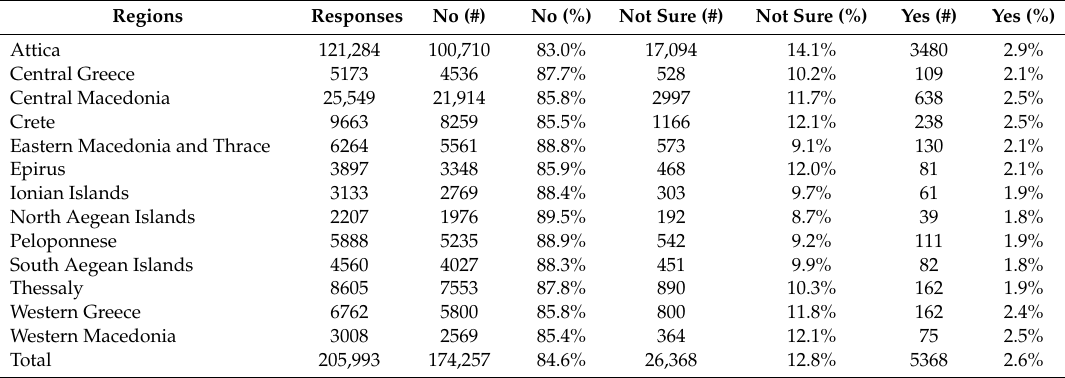
Figure 3. Spatial distribution of survey entries, the majority of which are located in the Regions of Attica and Central Macedonia. Black lines indicate geographical boundaries of the Regions. Green points indicate No, light green Not Sure and red points Yes answers; black circles indicate bigger cities. Table 2. Number (#) and percentages (%) of entries per answer option and per